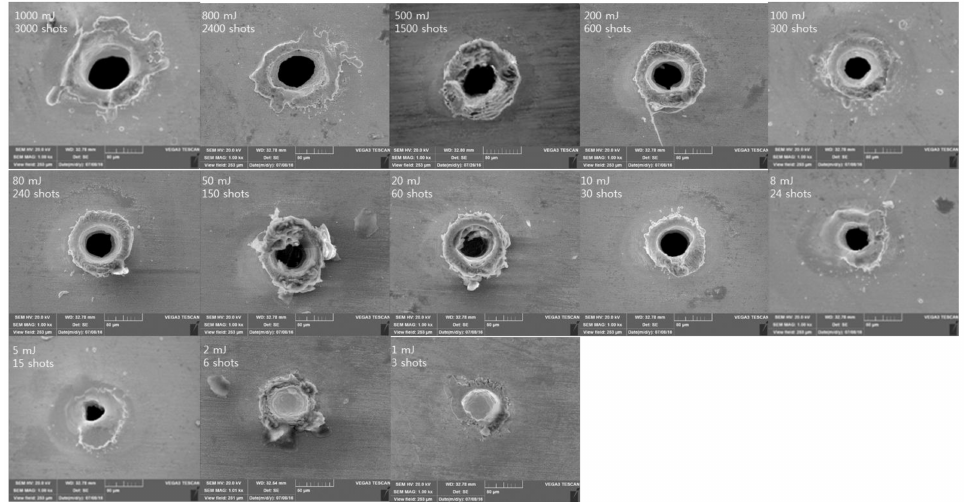
Figure 11. SEM images of laser ablation with ∆ t = 50 ns.